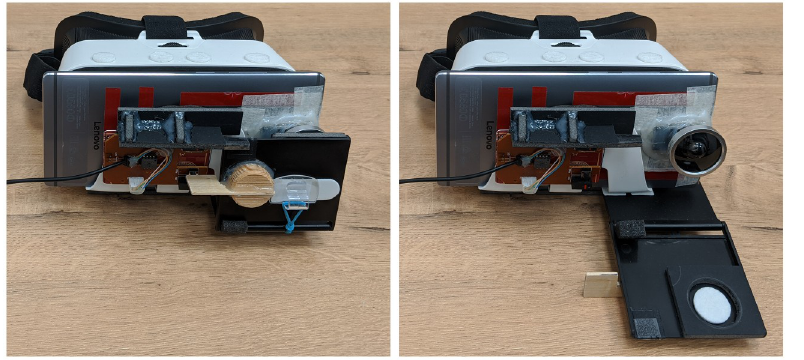
Fig 3. The AR device used in this study with its shutter panel closed (left) and opened (right).